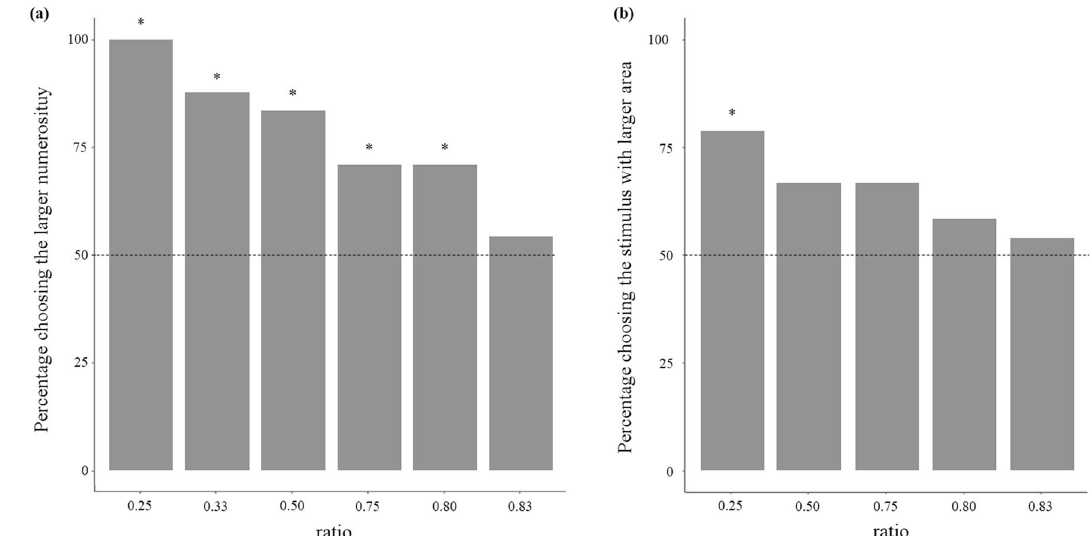
Figure 3. ( a ) Percentage of snails choosing the stimulus with larger quantity of bars in Experiment 1a and 1b. Snails showed a significant preference for larger quantity up to 4 versus 5 bars. There was a significant difference amongst the numerical ratios ( P < 0.001). Dotted line represents the expected preference by chance, and asterisks indicate significant deviations from the chance level ( P < 0.05). ( b ) Percentage of snails choosing the stimulus with larger area in Experiment 1c. Snails showed a significant preference for the larger stimulus only in the easiest discrimination (ratio 0.25; P = 0.004). Dotted line represents the expected preference by chance, and asterisks indicate significant deviations from the chance level ( P <